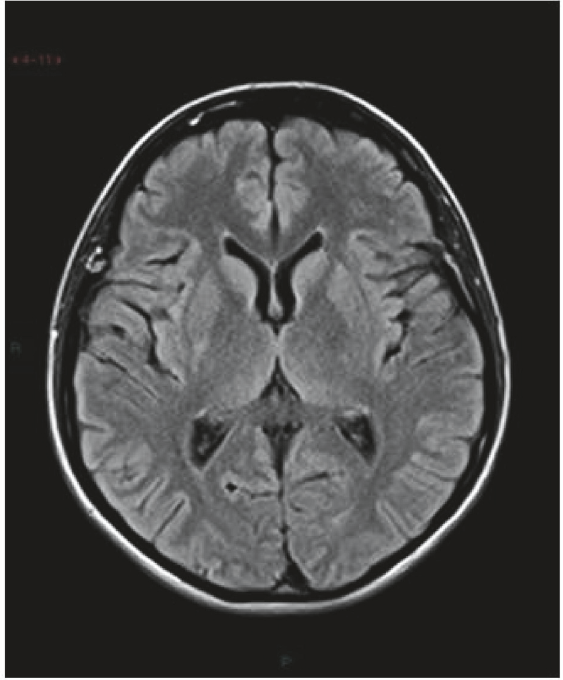
Figure 2: Magnetic resonance images performed 7 days after the first examination. There are no signs of foci of high signal